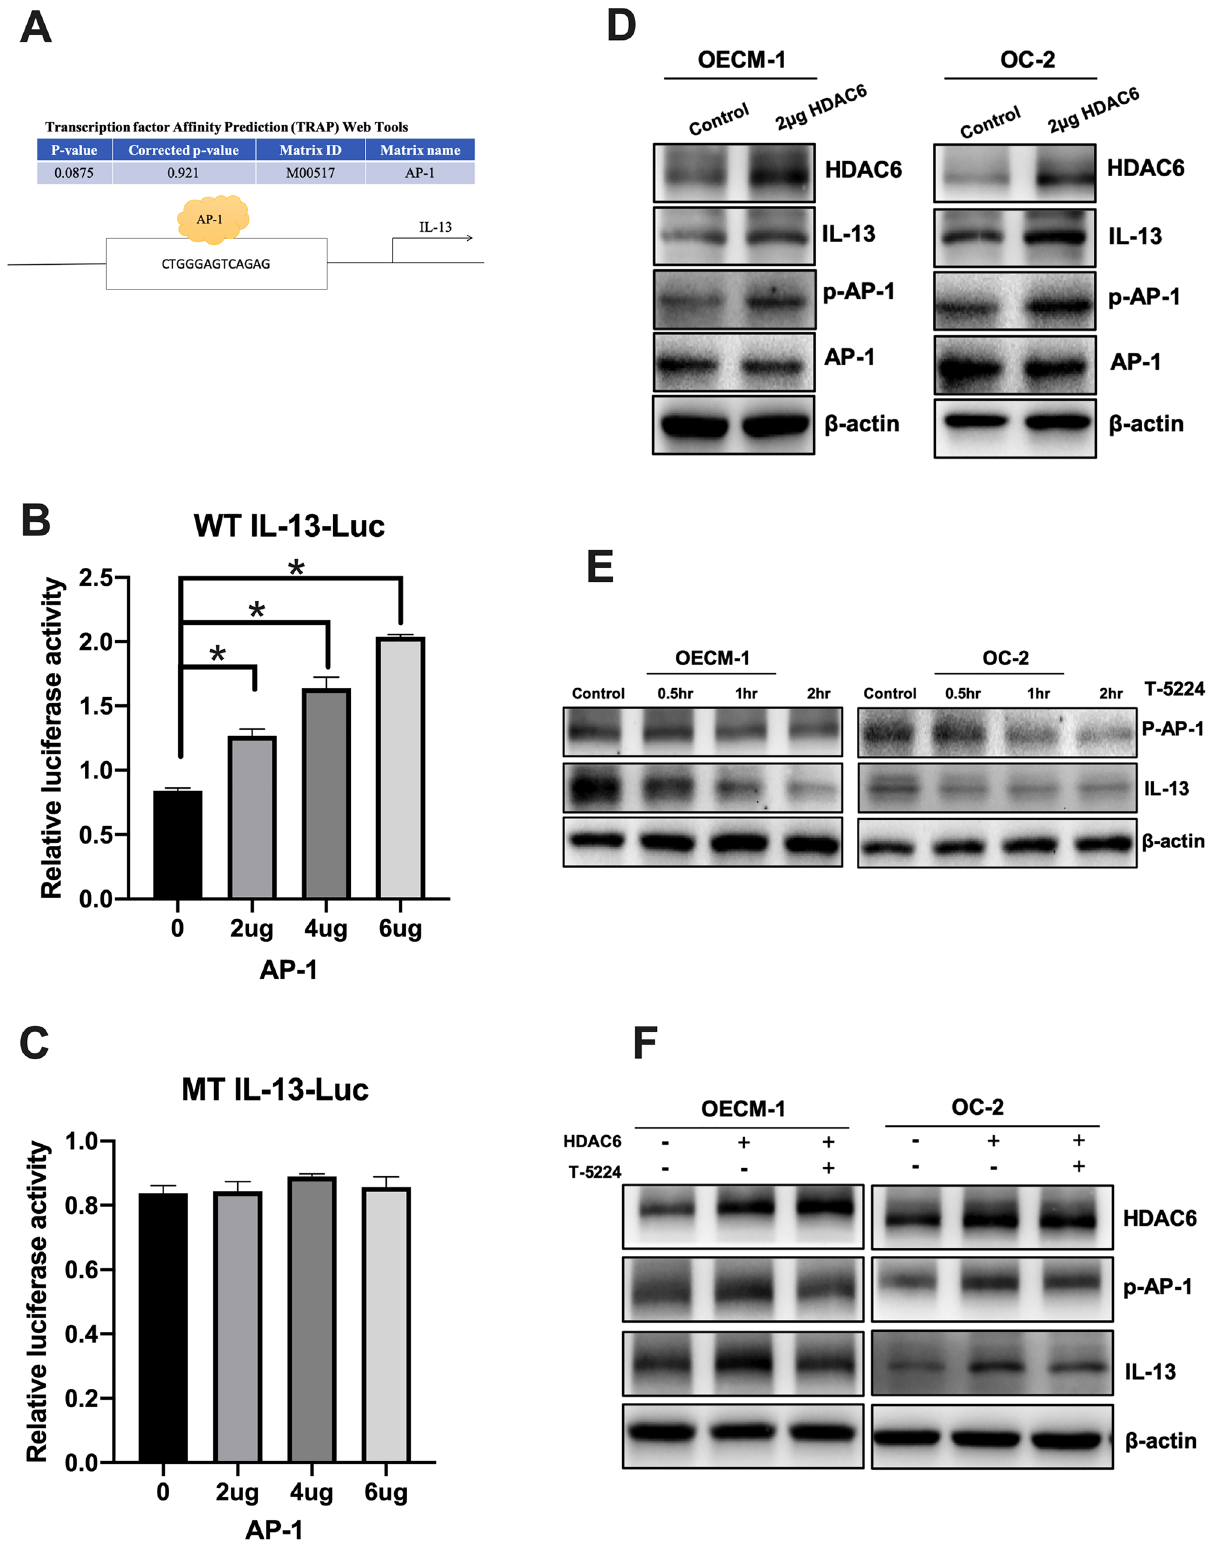
Figure 3. HDAC6 induced IL-13 expression via AP-1. ( A ) Transcription factor affinity prediction (TRAP) software predicted that the promoter region of IL-13 has an AP-1 transcription binding sequence. ( B , C ) pGL3-IL-13 luciferase plasmids containing wild- type (WT IL-13-Luc) or mutated (MT IL-13-Luc) 5 ′ -UTRs were constructed. 293 T cells were cotransfected with the IL-13 5 ′ -UTR plasmids and a plasmid expressing AP-1 at different dose ratios. ( D ) The HDAC6 plasmid (2 µg) was transfected into OECM-1 cells, and OC-2, HDAC6, IL-13, AP-1, p-AP-1 and B-actin were analyzed by western blotting. B-actin was used to normalize protein expression levels. ( E ) The AP-1 inhibitor T-5224 (40 µM) and (F) 2 µg of the HDAC6 plasmid were transfected into cells, and the level of IL-13 was analyzed by western